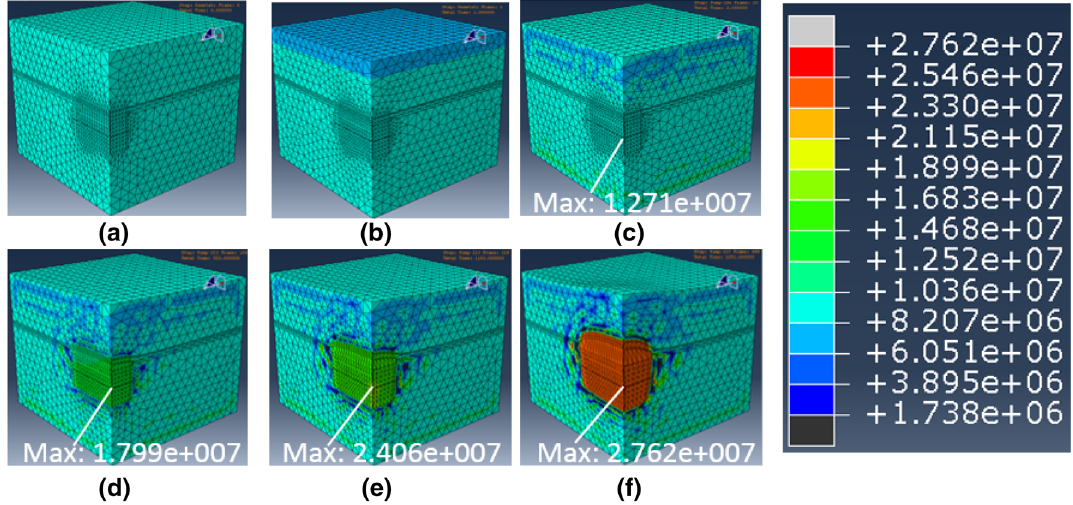
Fig. 4 Case 2 ( k = 45.9 mD): a pore pressure (Pa) following initial condition application, b pore pressure (Pa) following reservoir stresses and boundary conditions application on the domain, c t = 1 s, d t = 551 s, e t = 1101 s and f end of injection at t = 2250